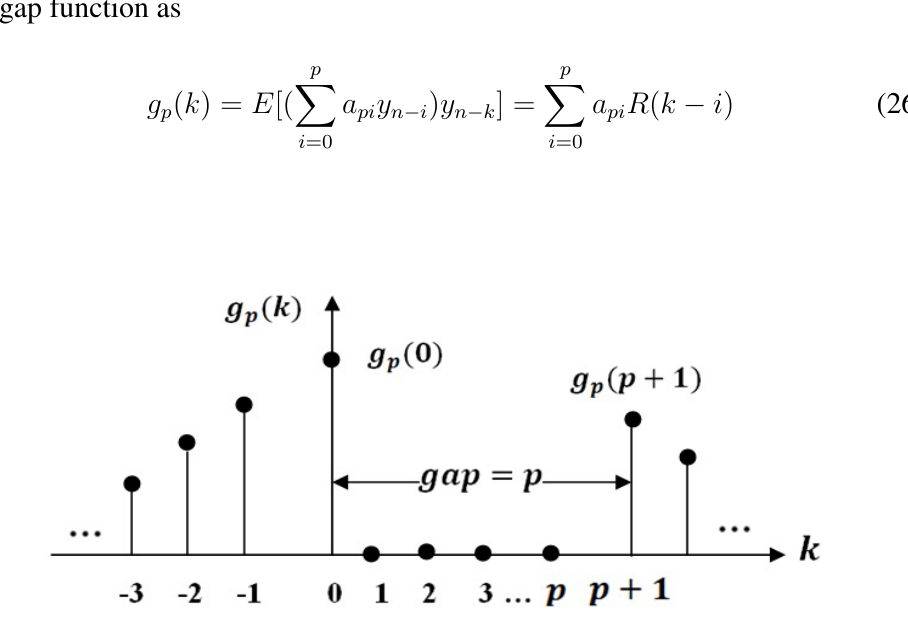
Figure 2: Gap conditions for the